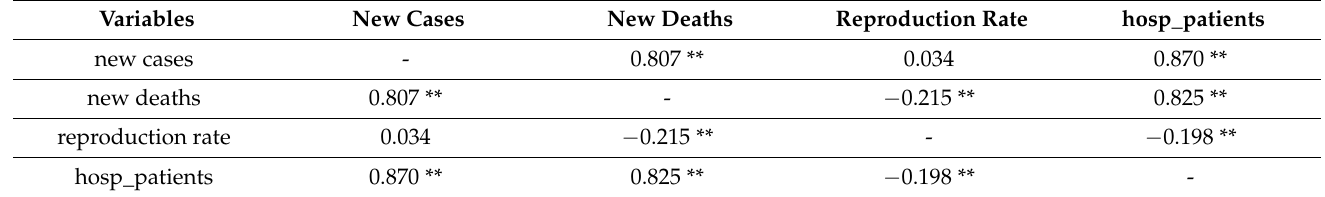
Table A3. Correlations between variables belonging to group Intensity of the disease in